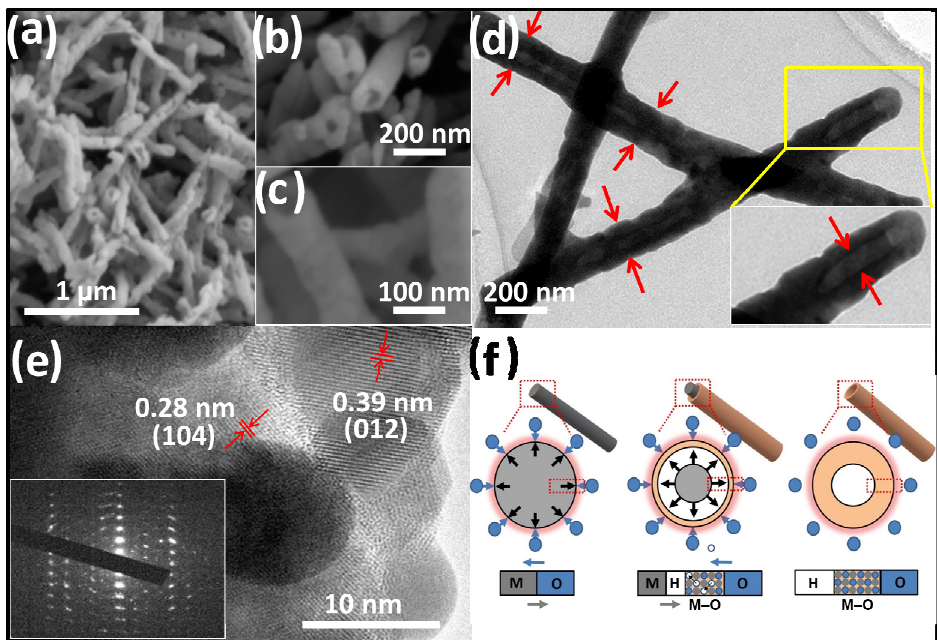
Fig. 1 Morphologies of Bi 0.9 Gd 0.07 La 0.03 FeO 3 nanotubes: (a–c) FESEM images, (d) TEM image, (e) HRTEM image with the SAED pattern inset, and (f) schematic illustration of the formation mechanism of the tubular